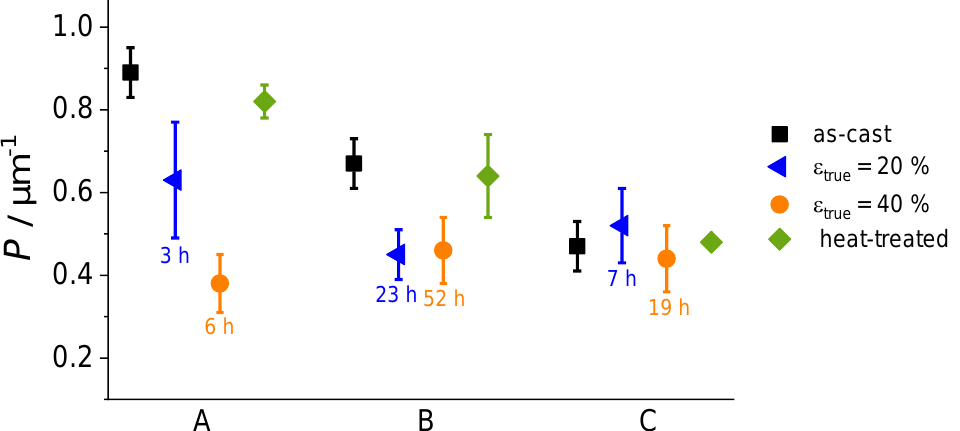
Figure 9. Phase boundary fraction of alloys A to C in as-cast condition (black squares), after creep deformation of 20 and 40% (blue triangles and orange circles, respectively) and after heat treatment at 1200 °C for 100 h (green diamonds). The durations of the compression creep tests are included as well.